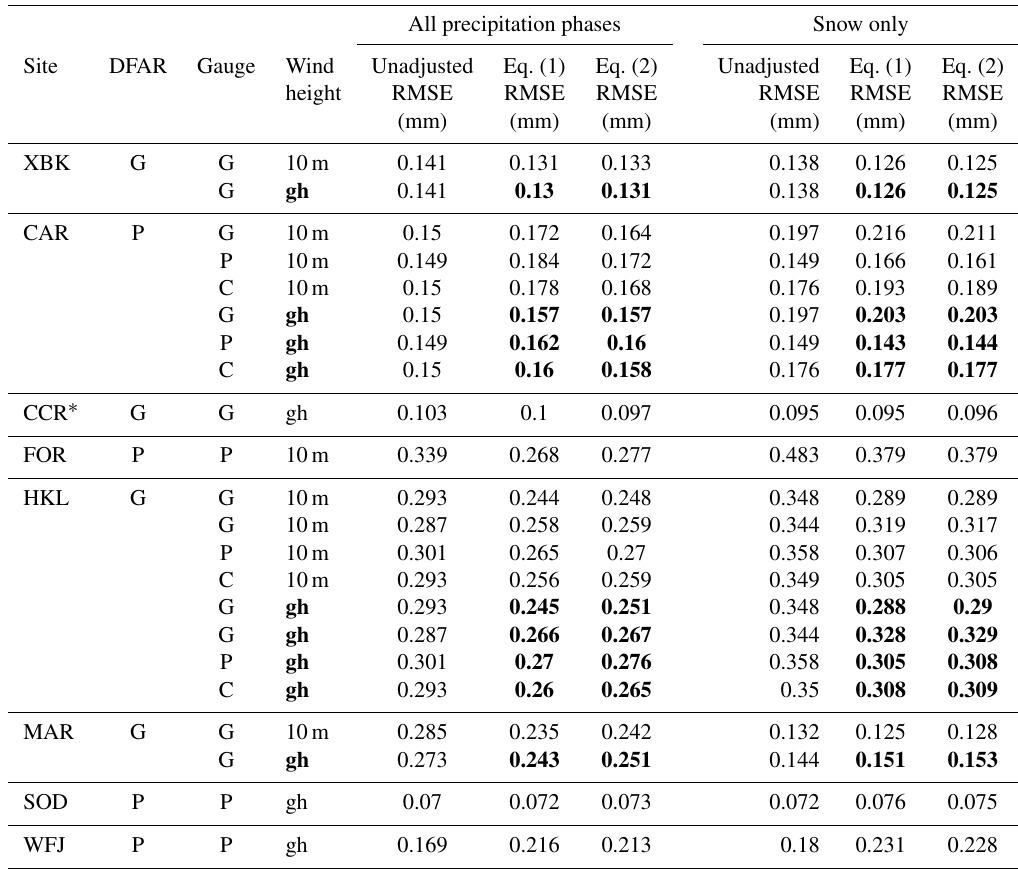
Table 4. Root mean square error (RMSE) for the single Alter-shielded gauges (G – Geonor; P – Pluvio 2 ) as compared to the DFAR reference at each site for the combined winters of 2015/2016 and 2016/2017 for available wind speed measurement heights (10m; gh – gauge height) and for Eqs. (1) and (2). Metrics are separated by precipitation phase (all and snow only). Where both wind speed heights are available, the gauge height data are shown in